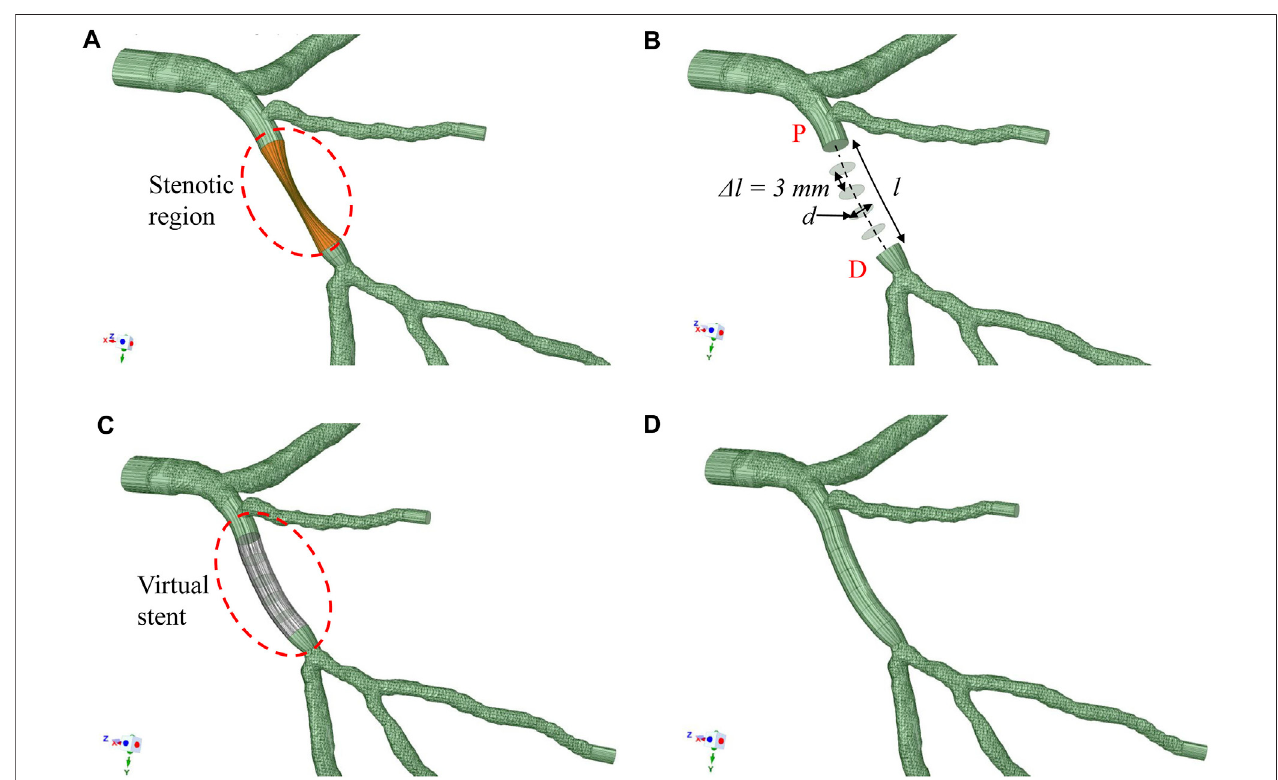
FIGURE 2 | Methodology to deploy stent (A) patient-speci fi c 3D model with the stenotic region highlighted (B) The diseased section is clipped between the proximal (P*) and distal (D*) locations. A series of circular surfaces are generated along and perpendicular to the original lumen centerline. These circular surfaces have diametersequaltothevirtualstentand spacedat3 mmintervalapartfromoneanother (C) Thesecircularsurfacesandoriginalsurfacesat “ P* ” and “ D* ” areinterpolated with B-spline interpolation to form a virtual stent segment (D) The virtual stent segment is merged with the rest of the segments in the original model to form a new model to mimic the post-stenting